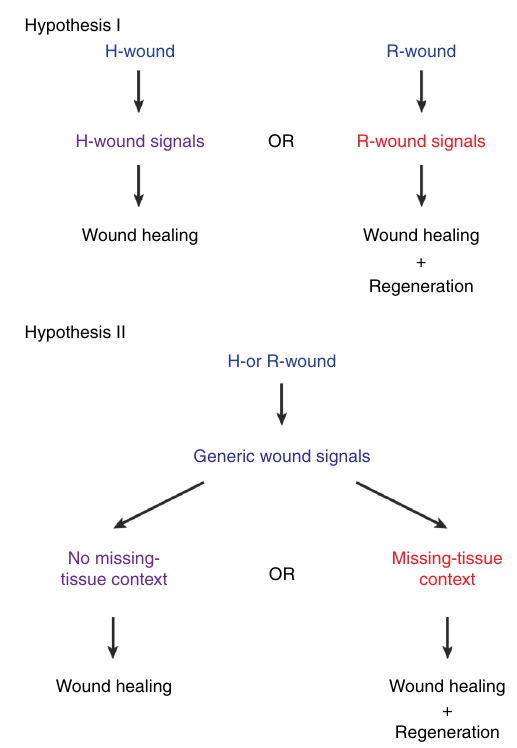
Fig. 1 Two hypotheses for generating regeneration initiation